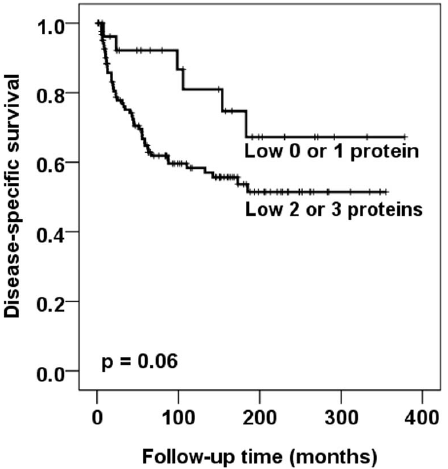
Figure 3. Survival curves using the Kaplan-Meier method for a subgroup of patients obtained surgical radicality (no rest tumor). The Kaplan-Meier curve of disease-specific survival in relation to the combined analysis of p14 ARF /p15 INK4b /p16 INK4a showed that patients whose tumors expressed low levels of two or three of these INK4 proteins had a worse prognosis than those with only low levels of one or no protein ( p =0.06).